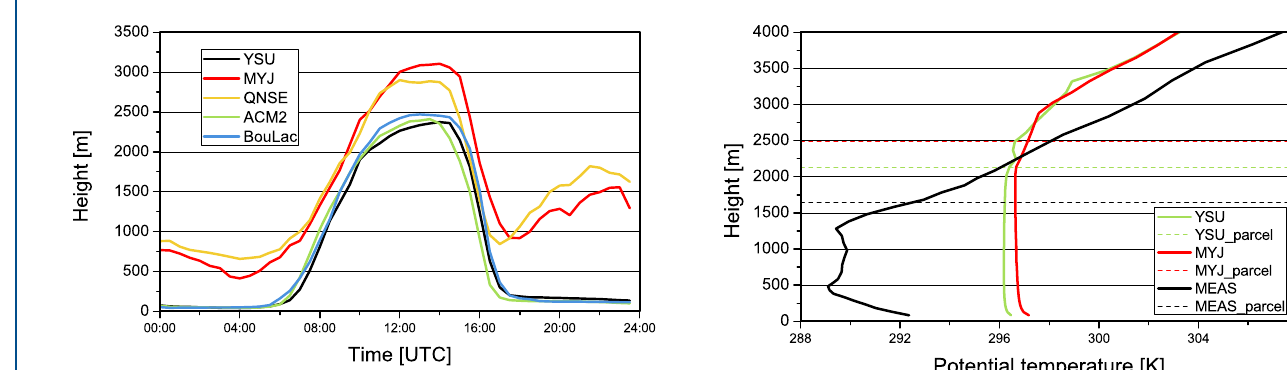
Figure 4. Measured and simulated potential temperature profile and parcel method estimated PBL heights (dashed lines) on 17 July 2012 at 12 UTC.